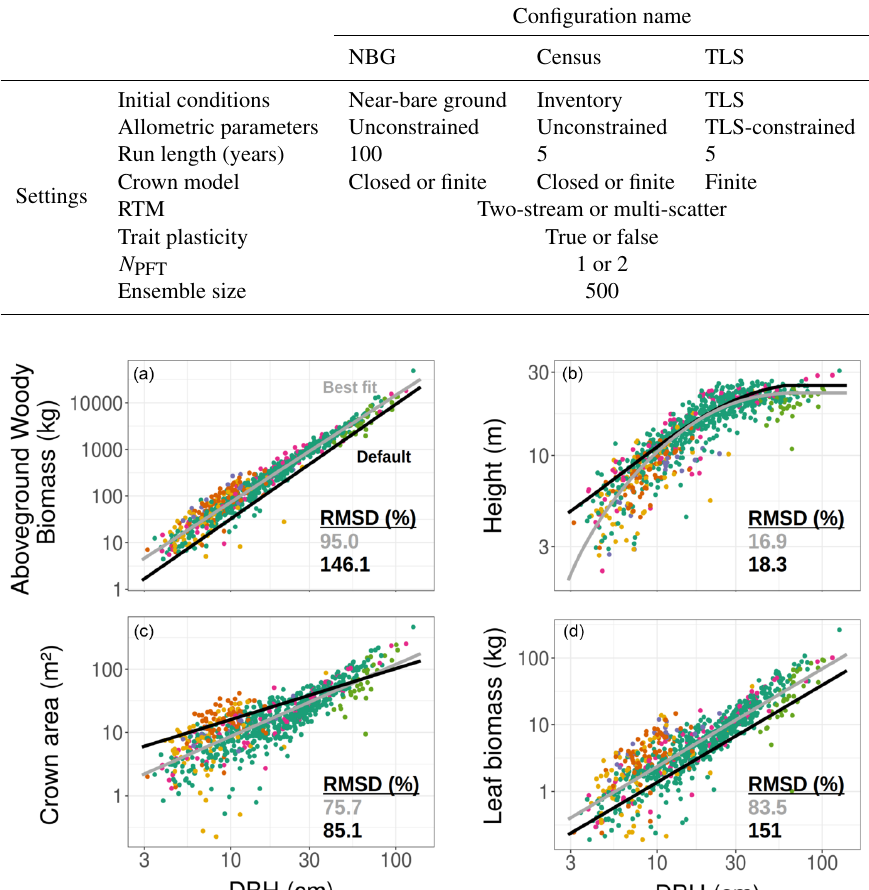
Figure 2. TLS-derived (grey, considering all tree species belonging to a single PFT) and model default (black, mid-successional hardwood trees in ED2) allometries for the aboveground woody biomass (a) , tree height (b) , crown area (c) , and leaf biomass (d) . The data to which the TLS allometries were fitted (coloured points corresponding to the tree species detailed in Fig. 1) were obtained using TLS. The coefficients used to plot the best fit and default allometries can be found in Table